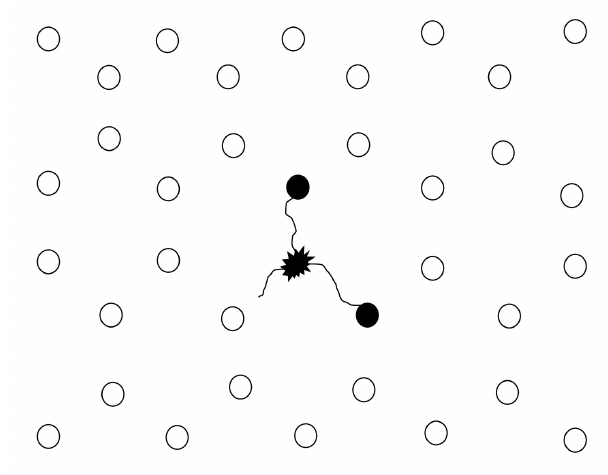
Figure 2: At each step of plasmodium propagation, there are only three attractants which can be occu- pied. At the first time step the plasmodium expan- sion is coded by the 4-adic integer . . . 000002.